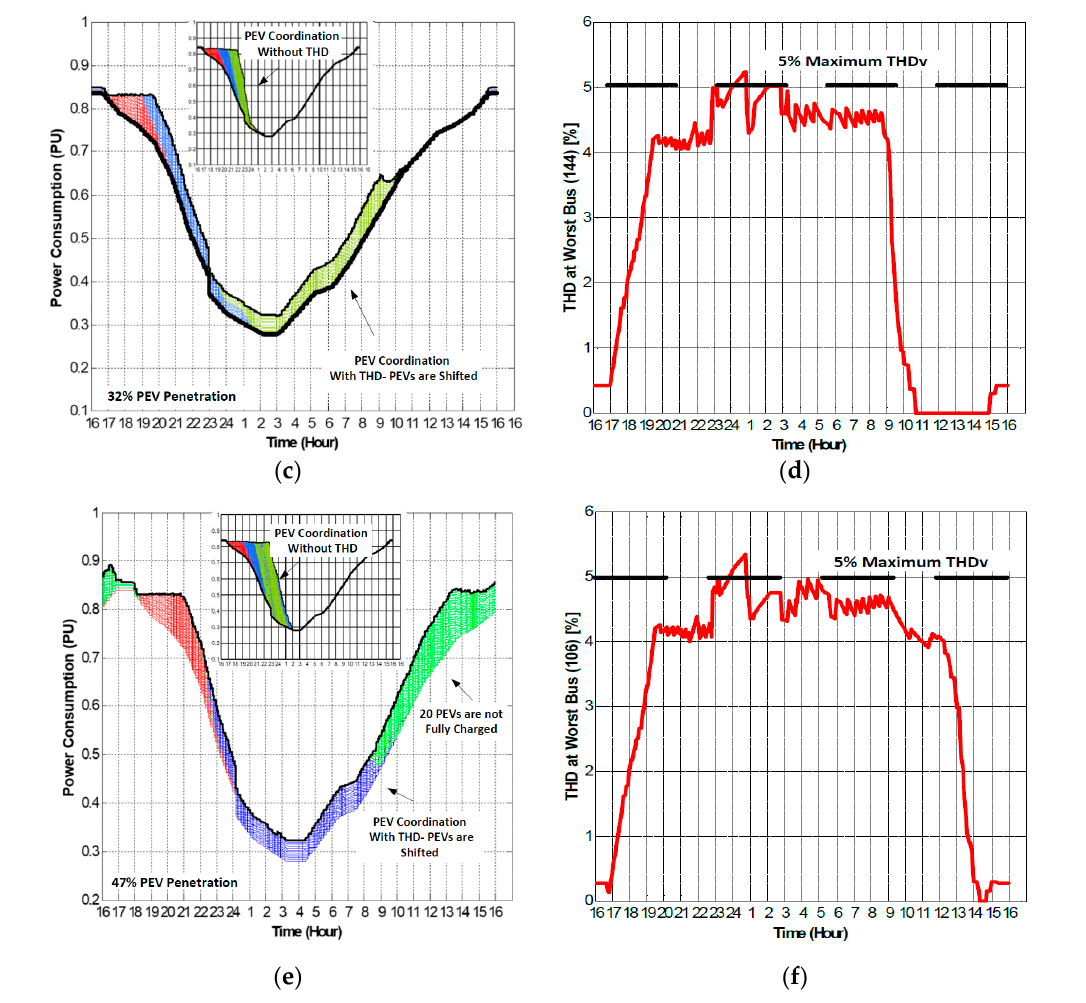
Figure 6. Simulation results for Case 2: NOL-MSSCA considering harmonics including power consumption and THDv of ( a , b ) 16% PEV charging penetration; ( c , d ) 32% PEV charging penetration; ( e , f ) 47% PEV charging penetration.